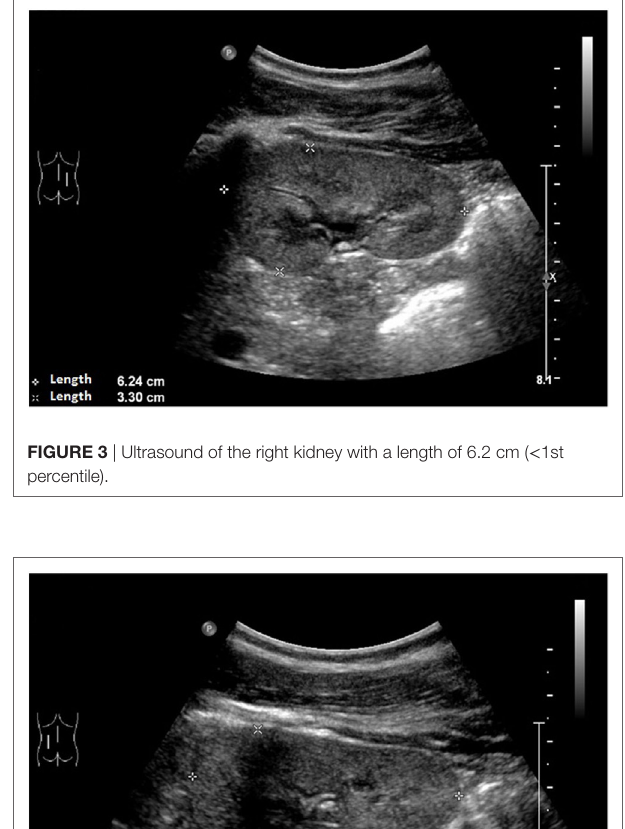
FIgURe 2 | Growth and weight charts of the patient. These charts are gender specific and refer to boys. x -axis, age (years); y -axis, height (centimeter, upper part of the figure) and weight (kilograms, lower part of the figure).